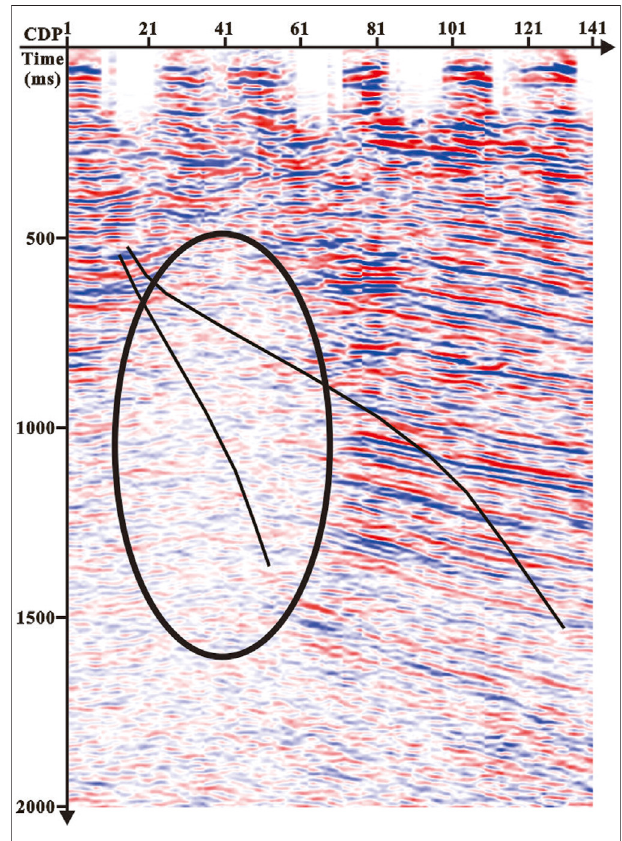
FIGURE 9 | Seismic imaging section across the wells.